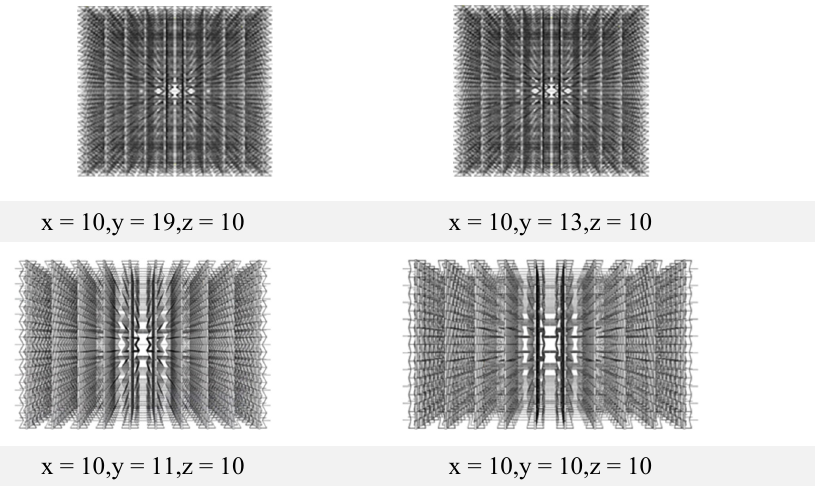
Figure 6. Number of different structural cells.